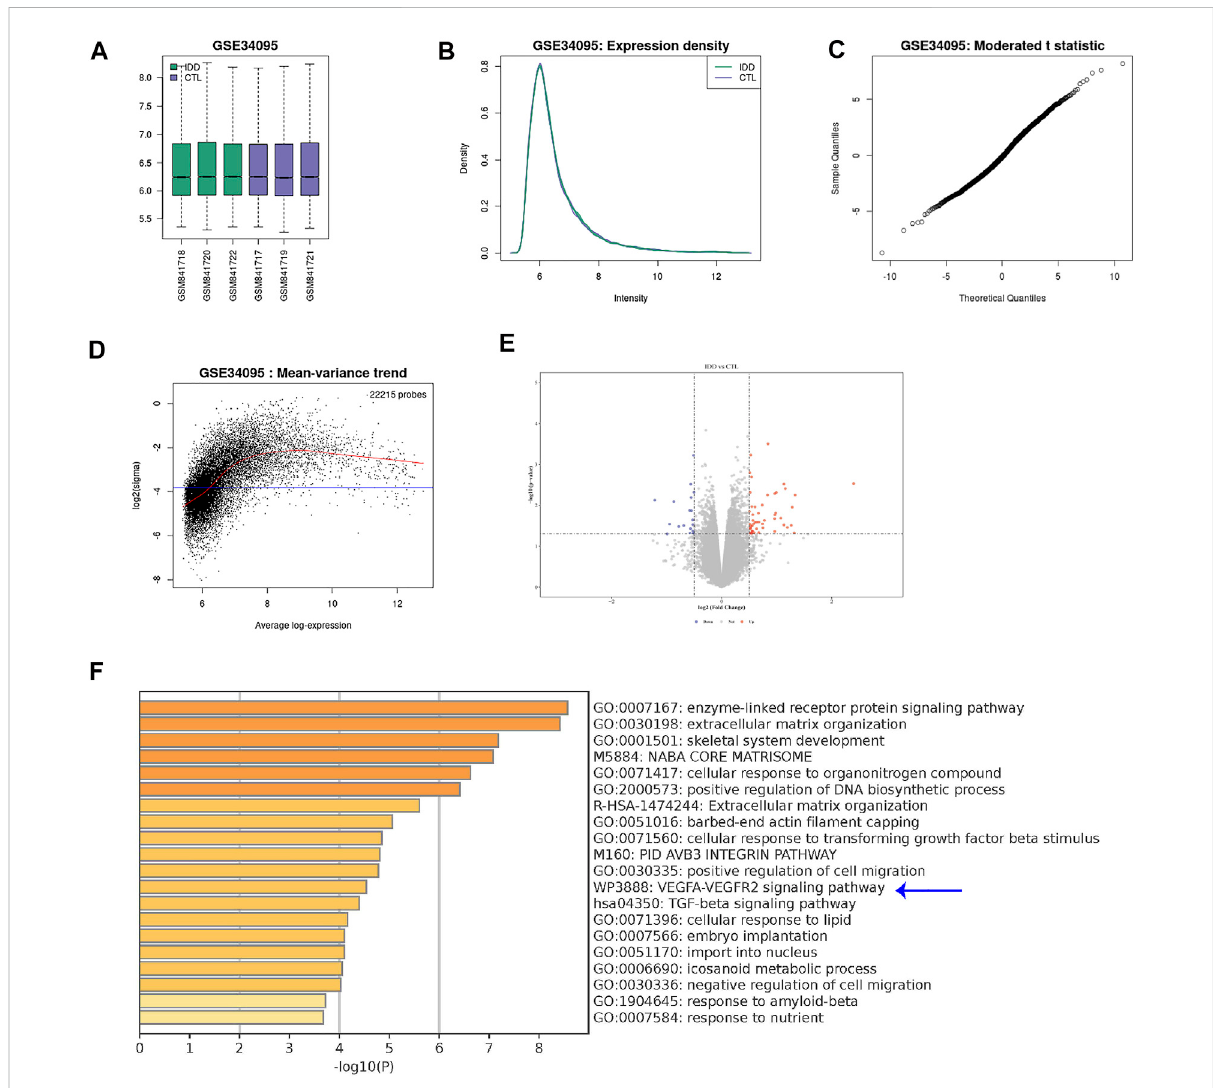
FIGURE 2 VEGF-A signaling is activated in discs from LDD. A GEO database (GSE34095) including 3 LDD specimens and 3 controls was analyzed. (A) Principal component analysis (PCA). (B) Expression density. (C) Moderated t statistic test. (D) Mean-variance trend. (E) A volcano map showing differential genes upregulated or downregulated in LDD, compared to controls. (F) KEGG pathway analysis showed that VEGF-A signaling pathway (blue arrow) was a major altered